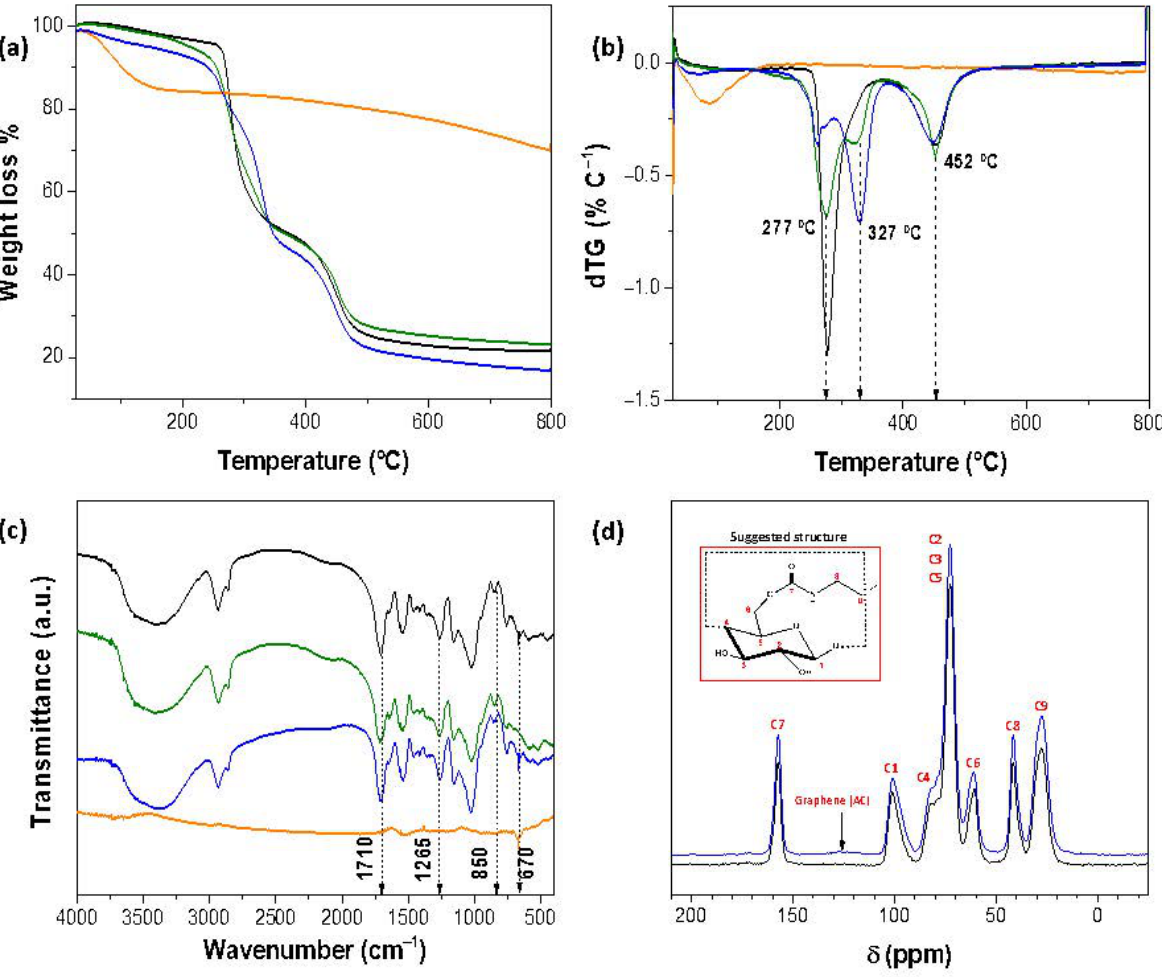
Figure 2. Thermograms ( a ) and corresponding dTGs ( b ) for PCD (black line), PCD/AC 5% (green line), PCD/AC 10% (blue line) and AC (orange line). FTIR and 13 C CPMAS solid state NMR spectra are shown in ( c , d ),